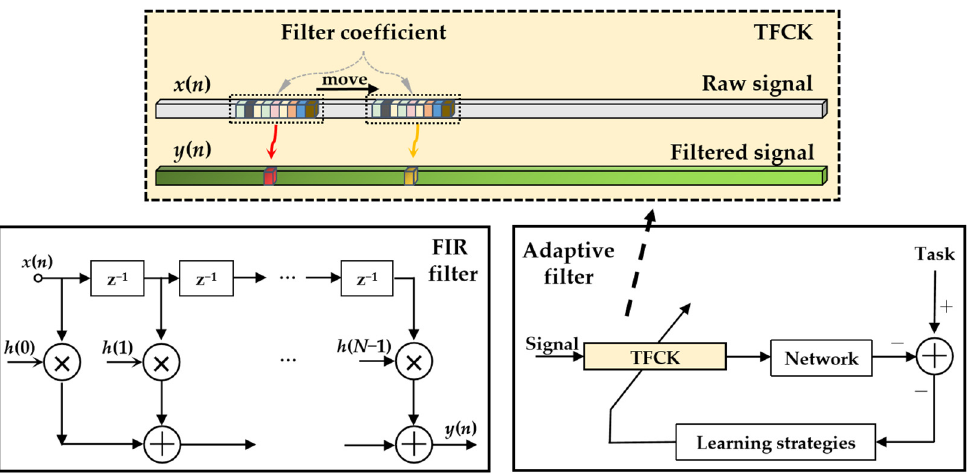
Figure 2. The schematic diagram of TFCK.